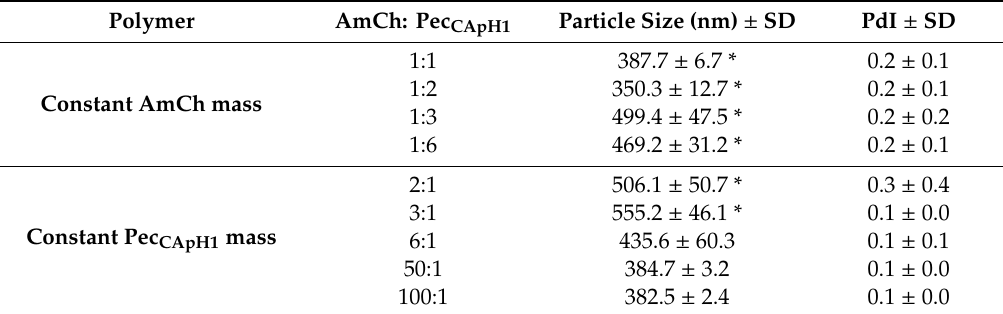
Table 4. E ff ect of mass ratio of AmCh:Pec CApH1 on the particle size and PdI of the polyelectrolyte